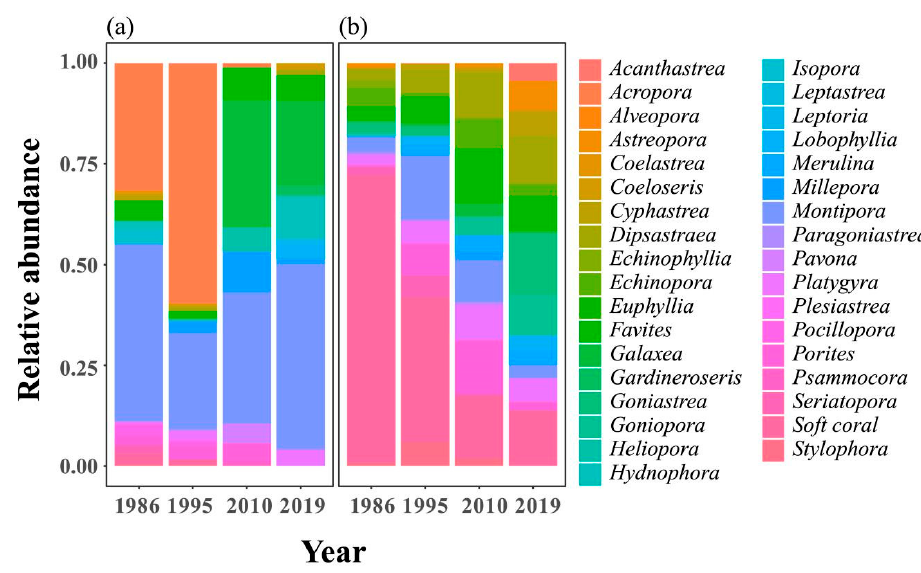
Figure 7. The relative abundance of coral genera at ( a ) 3 m (shallow) and ( b ) 7 m (deep) in NPP OL in 1986, 1995, 2010, and 2019. This figure was redrawn using data in (Keshavmurthy, S. etc. 2014) and combined with a survey conducted in